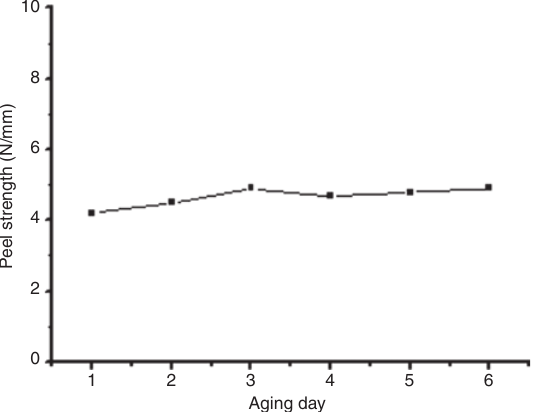
Figure 3: Peel strength between CR and polyester tire cord at 90 ° C for various aging durations.